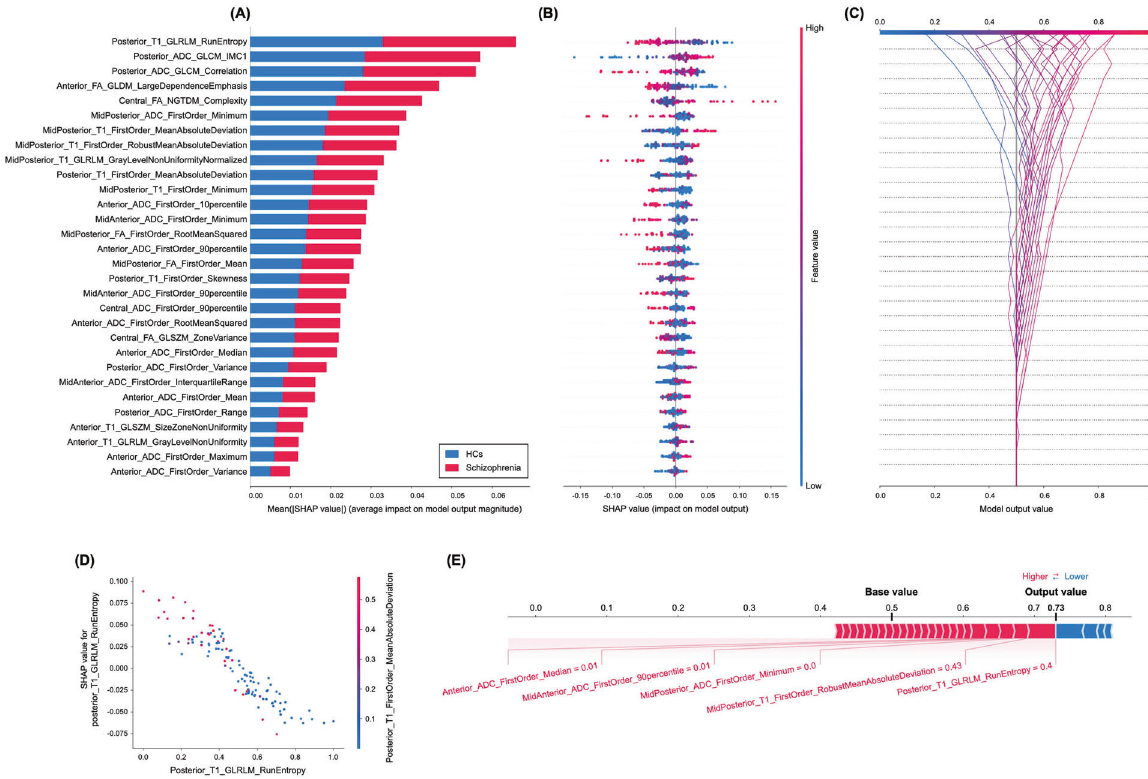
Fig. 3 Model interpretability of the radiomics model for the diagnosis of schizophrenia with SHAP. A Variance importance plot listing the most signi fi cant variables in descending order. The top variables (such as posterior_T1_GLRLM_run entropy, posterior_ADC_GLCM_IMC1, and posterior_ADC_GLCM_correlation features) contribute more to the model than the bottom ones and thus have higher predictive power. B Summary plot of feature impact on the decision of the radiomics model and interaction between radiomics features in the model. A positive SHAP value indicates an increase in the risk of predicting schizophrenia and vice versa. The high value corresponds to a higher risk of schizophrenia. Each point corresponds to a prediction in each participant. C Decision plot showing how the radiomics model predicts schizophrenia. Moving from the bottom of the plot to the top, SHAP values for each feature are added to the model ’ s base value showing how each feature contributes to the overall prediction of schizophrenia. D An example of the dependence plot of the posterior_T1_GLRLM_run entropy feature, which is the top-most important feature. The plot shows how there is an approximately linear and negative trend between “ posterior_T1_GLRLM_RunEntropy ” and schizophrenia prediction, and that the “ posterior_T1_GLRLM_RunEntropy ” interacts with “ poster- ior_T1_FirstOrder_MeanAbsoluteDeviation ” frequently. E Force plot of a representative case of participants with schizophrenia from the test set, showing local interpretability. Note that the posterior_T1_GLRLM_RunEntropy largely pushes the model prediction score into the higher direction from the base